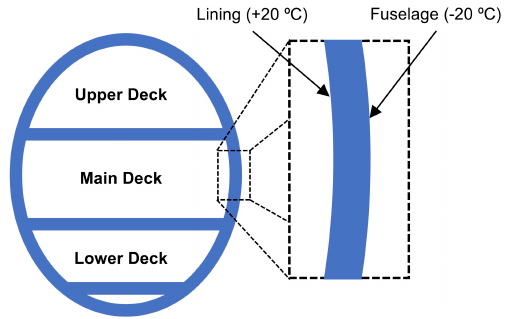
Figure 24. Possible installation of TEGs in airplanes’ fuselage lining [162].